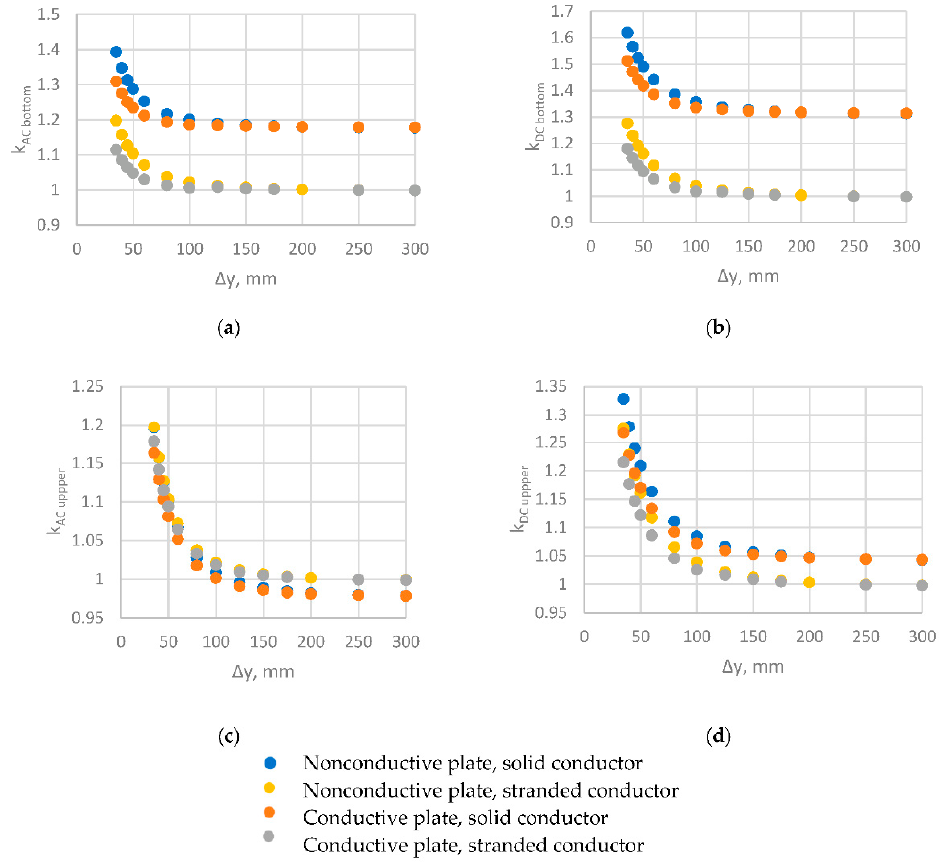
Figure 5. Correction factors: ( a ) k AC bottom ; ( b ) k DC bottom ( c ) k AC upper ; ( d ) k DC upper for ∆ x = 35 as a function of core plate distance.